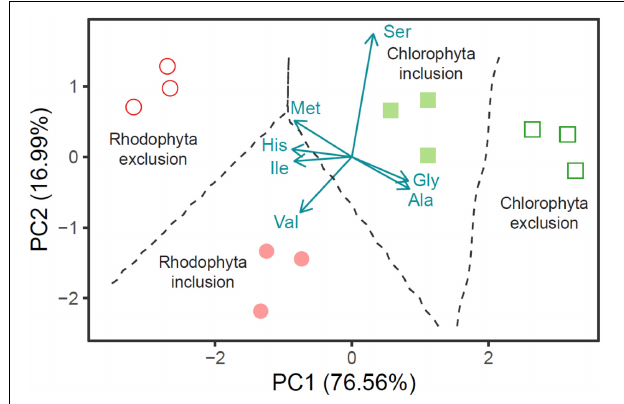
FIGURE 4 | Principal component analyses (PCA) based on the seven most discriminate amino acid δ 13 C variables for separating Atlantic salmon ( n = 3 in each group) fed composite diets with (15%) and without Rhodophyta and Chlorophyta ingredients. Values in parentheses are the percentage variations accounted by each PC axis (76.6 and 17.0% for PC1 and PC2, respectively), and the broken lines represent the decision boundaries. The data were compiled from Wang et al.